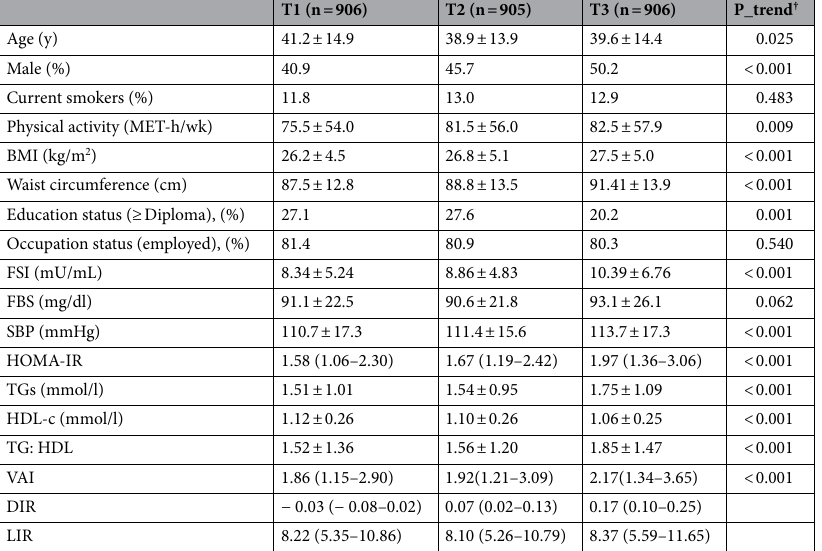
Table 1. Baseline characteristics across tertiles of the DIR among 2717 participants of the third examination of the Tehran Lipid and Glucose Study (2006–2008). Data are presented as mean ± SD or median (IQR) for continuous, and percent and categorical variables. BMI body mass index, FSI fasting serum insulin, FBS fasting blood sugar, SBP systolic blood pressure, HOMA-IR the homeostasis model assessment-estimated insulin resistance, TGs triglycerides, HDL-c high-density lipoprotein cholesterol, VAI visceral adiposity index. † P for trend was calculated using linear regression and chi-square test for continuous and categorical variables, respectively.